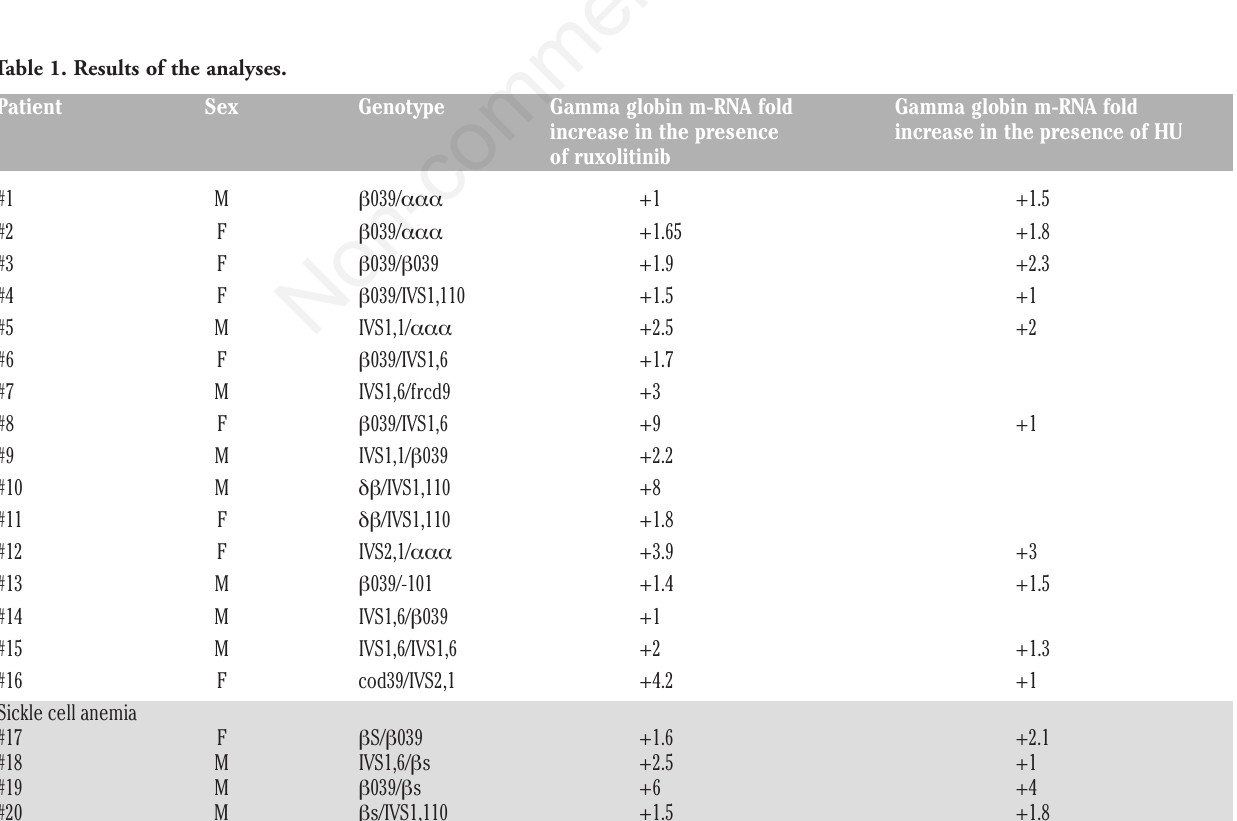
Table 1. Results of the